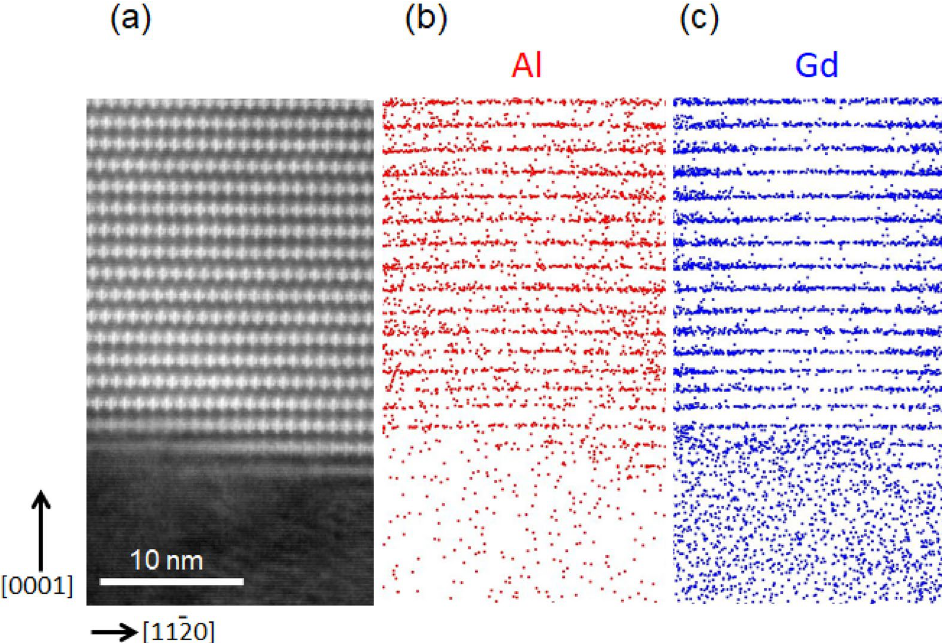
) 00] direction. ( b , c ) 15-nm-thick sliced APT maps Figure 3. ( a ) HAADF-STEM image taken along the [1 1 ( − for Al and Gd in the same region as the STEM image around the interface region of the LPSO/OD and α-Mg phases. Software: ( a ) Gatan Microscopy Suite (GMS), Ver. 2.30.542.0, https ://www.gatan .com/produ cts/tem- analy sis/gatan -micro scopy -suite -softw are, ( b , c ) Integrated Visualization and Analysis Software (IVAS), Ver. 3.6.14, https ://www.camec a.com/servi ce/softw